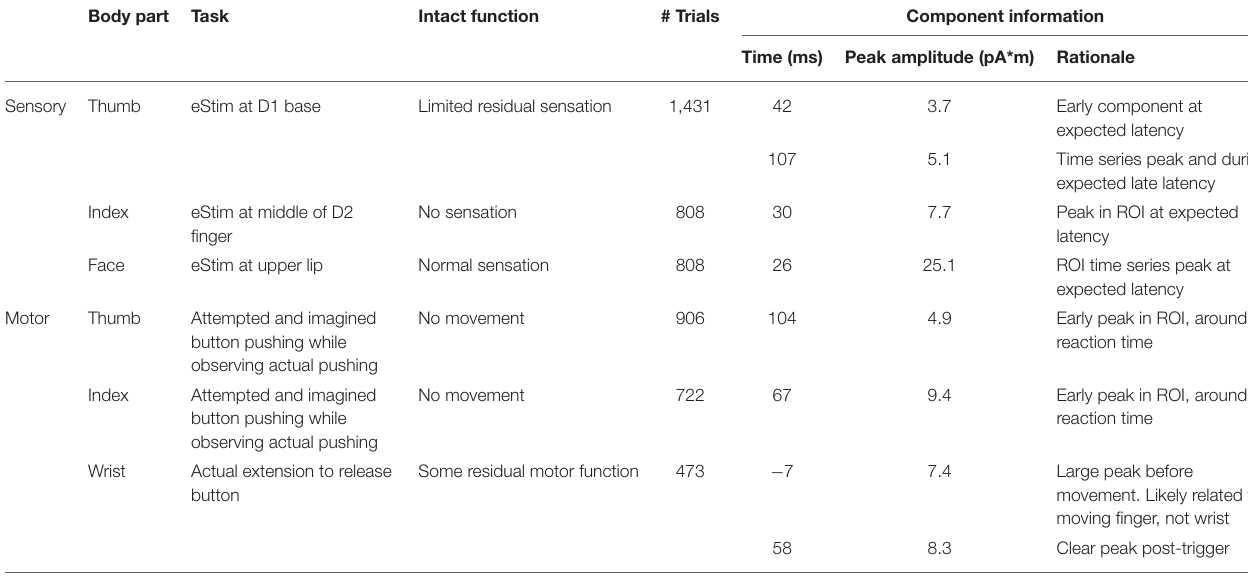
TABLE 1 | Mapping parameters. Body part